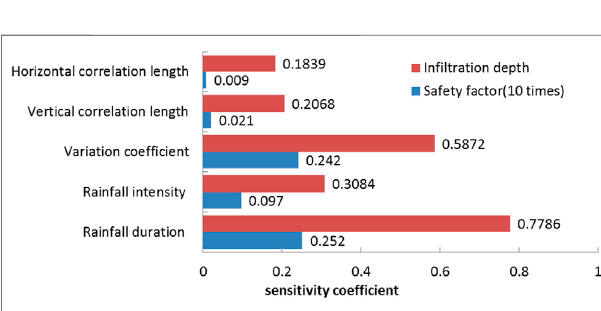
FIGURE 12 | Sensitivity coef fi cient of in fi ltration depth and safety factor to different parameters.